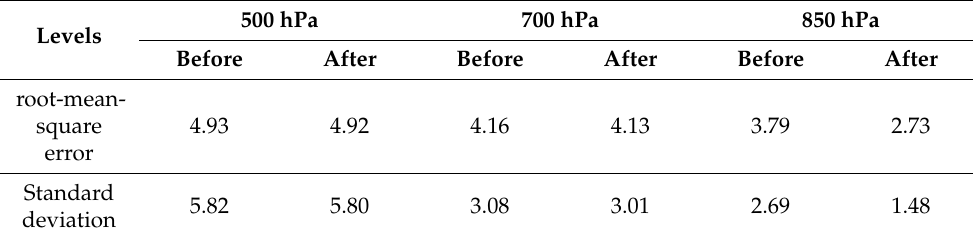
Table 5. RMSE and SD for 2017–2018 dew point measurements before and after correction. 500 hPa 700 hPa 850 hPa Levels Before After Before After Before After root-mean- square 4.93 4.92 4.16 4.13 3.79 2.73 error Standard deviation